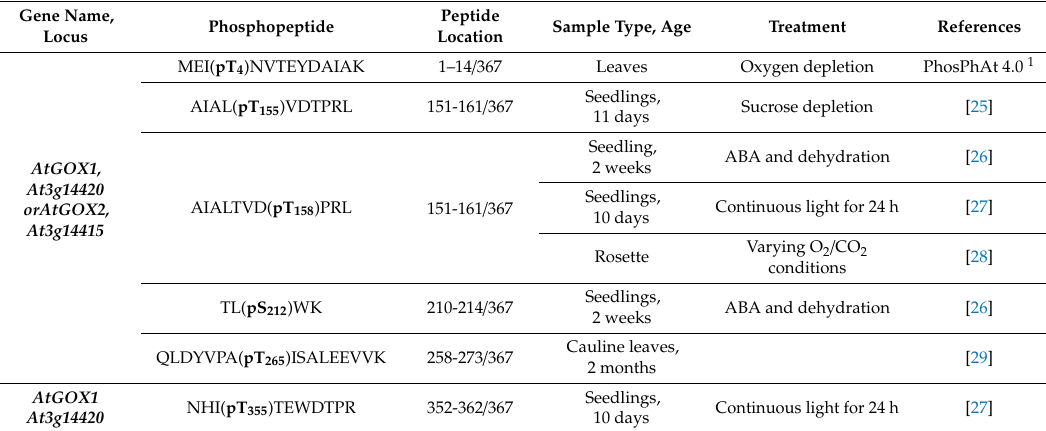
Table 1. Phosphopeptides associated with At GOX1 and At